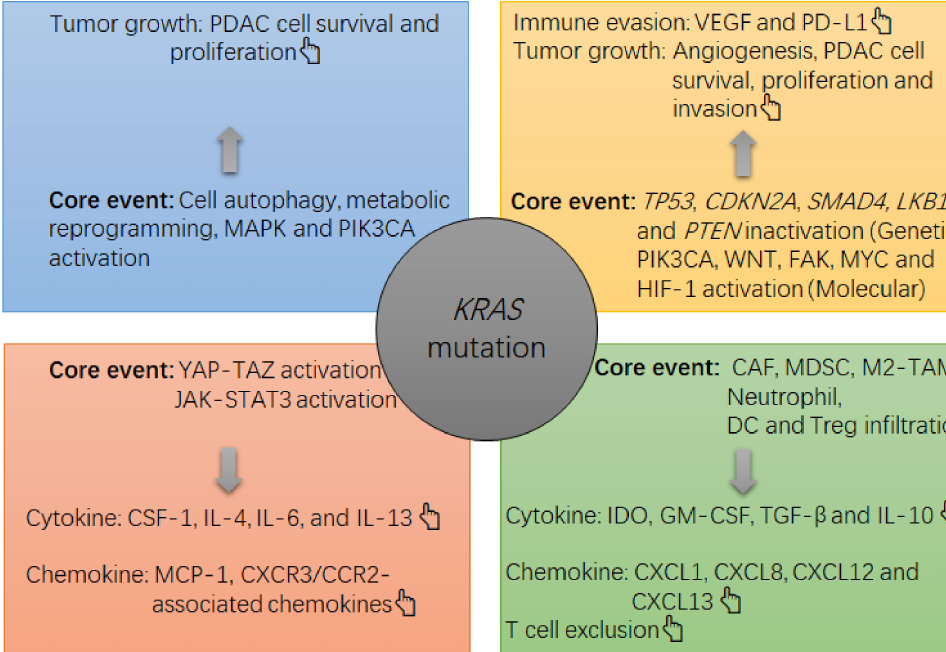
Figure 1. The note chart of KRAS mutation-induced growth and immunosuppression in PDAC tumors. The KRAS mutation causes a suppressive milieu in PDAC tumors mainly via the following routes, such as activation of mitogen-activated protein kinase (MAPK) and phosphatidylinositol 3-kinase (PI3K)-Akt, activation of YAP-TAZ and JAK-STAT3, and induction of cell autophagy and metabolic reprogramming in PDAC cells. In this context, the survival and proliferation of PDAC cells will be accelerated, and an overgrowth of tumor cells can cause a hypoxia within the tumor, which then activates hypoxia-induced factor 1 (HIF-1) α to upregulate the expression of gene encoding vascular endothelial growth factor (VEGF) by PDAC cells. VEGF is a potent cytokine that induces angiogenesis and immune evasion (e.g., programmed death ligand 1 (PD-L1) upregulation and tumoricidal T cell exhaustion). Meanwhile, PDAC cells can increase their production of suppressive cytokines and chemokines, such as interleukin 4 (IL-4), IL-6, IL-13, macrophage-colony stimulating factor 1 (CSF-1) and monocyte chemotactic protein 1 (MCP-1), which then recruit and increase the survival and suppressive function of immune infiltrates including cancer-associated fibroblasts (CAFs), MDSCs, M2-like tumor-associated macrophages (TAMs), indoleamine 2, 3-dioxygenase (IDO)-producing dendritic cells (DCs) and regulatory T cells (Treg cells). In this context, an overload of suppressive cells will increase the local levels of suppressive cytokines and chemokines, such as transforming growth factor-beta (TGF- β ), IDO, IL-10, granulocyte-macrophage colony stimulating factor (GM-CSF), chemokine C-X-C motif ligand 1 (CXCL1), CXCL8, CXCL12 and CXCL13, thus strengthening the immunosuppression in the tumor (e.g., tumoricidal T cell exclusion). In concert with the KRAS mutation, other alterations at genetic and molecular levels, such as liver kinase B1 gene ( LKB1 ) inactivation, TP53 inactivation, phosphatase and tensin homolog gene ( PTEN ) inactivation, focal adhesion kinase (FAK) activation, phosphatidylinositol-4, 5-bisphosphate 3-kinase catalytic subunit alpha (PIK3CA) activation or Wingless/Integrated (WNT) activation, also contribute to the tumor growth (e.g., PDAC cell survival, proliferation and invasion) and immune evasion (PD-L1